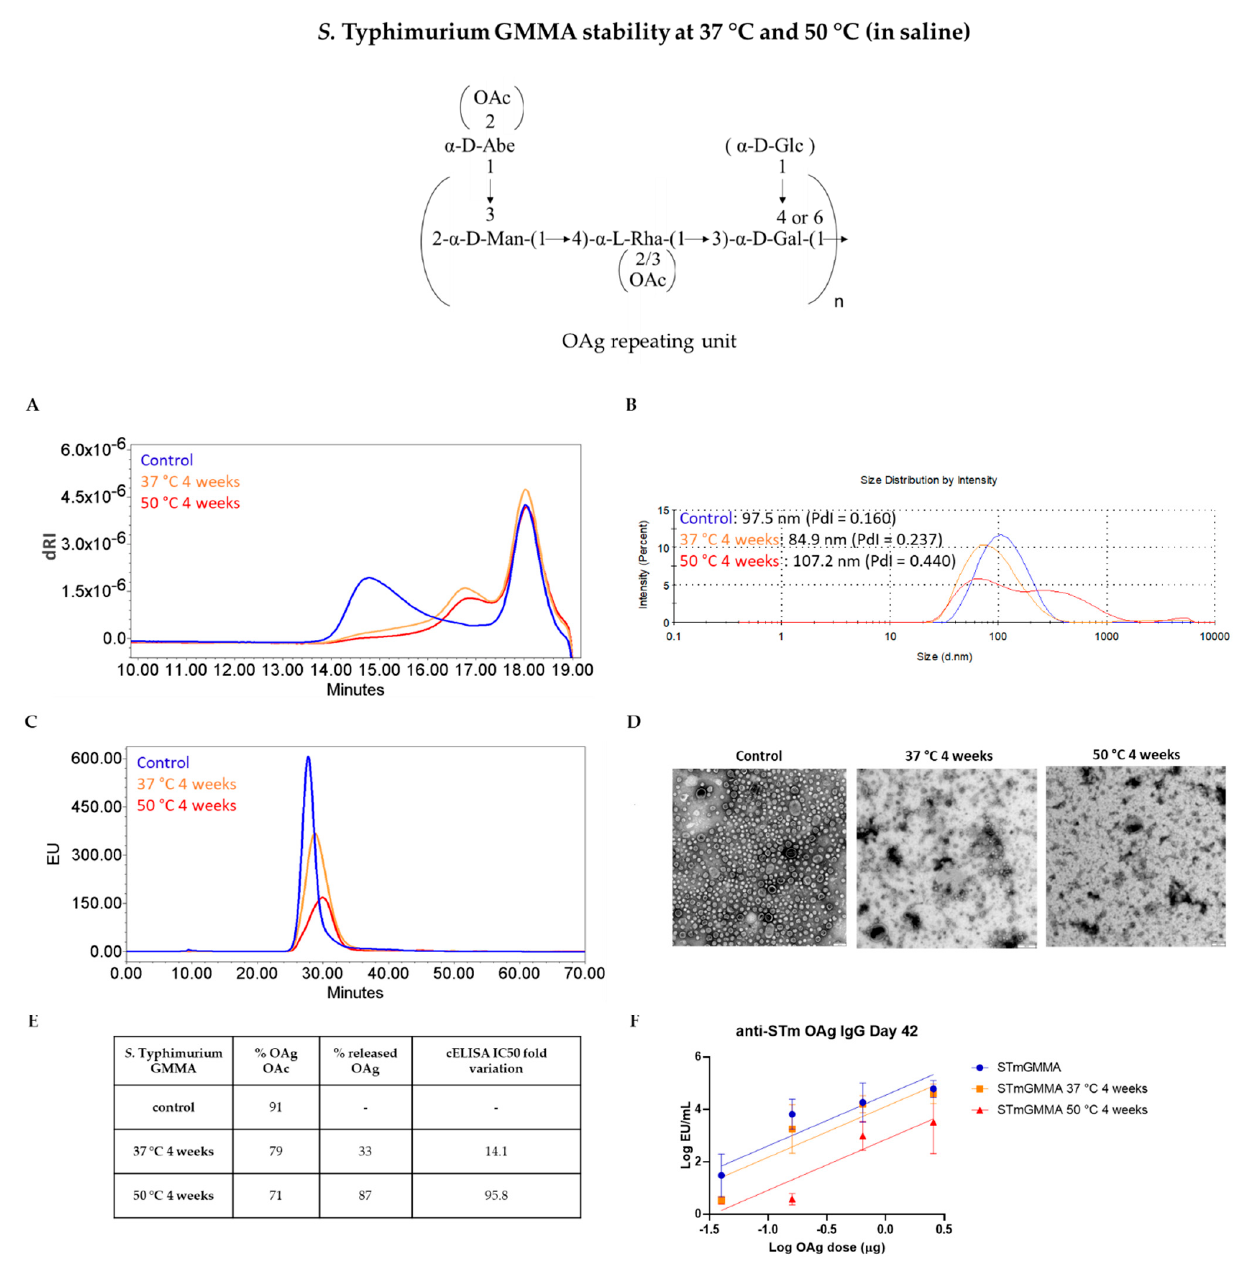
Figure 3. Characterization of S. Typhimurium GMMA stressed for 4 weeks at 37 °C or 50 °C: ( A ) HPLC-SEC analysis of extracted OAg from GMMA samples; ( B ) DLS, ( C ) HPLC-SEC and ( D ) TEM analyses performed on GMMA: disruption and aggregation of GMMA start after one month at 37 °C with a worsening trend visible at the higher temperature of 50 °C (scale bar = 100 nm). ( E ) Summary table with OAg O-acetylation levels, percentage of OAg detached from GMMA membrane, and cELISA IC50 fold variation. ( F ) Stressed GMMA were tested in mice: animals were immunized at day 0 and 28 and anti-OAg IgG response determined by ELISA at day 42 in single sera from each group. The graph reports parallel lines (log transformed ELISA units vs. log transformed μ g OAg dose) where Y-intercepts of the dose–response curves are compared ( p -value = 0.0177).